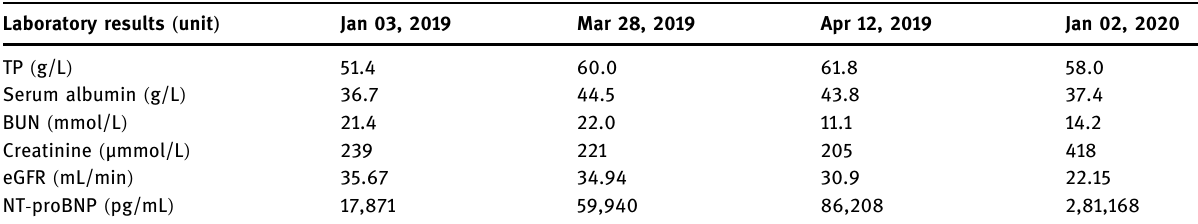
Table 1: Laboratory results during hospitalization Laboratory results ( unit )